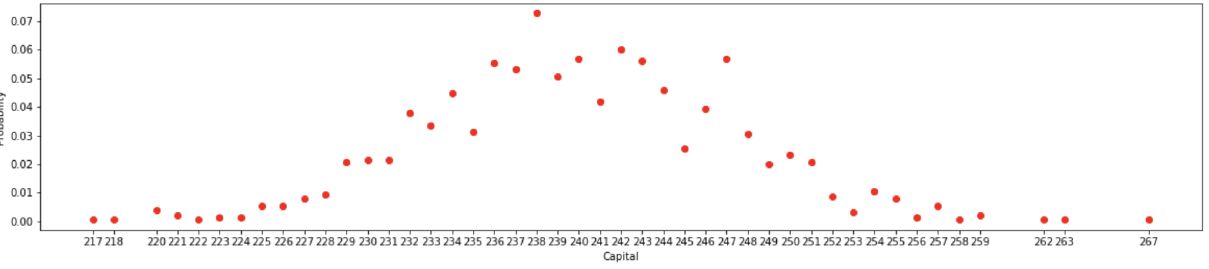
Figure 3. Probability of potential capital R(t) for u = 200, c = 20, m = 15, σ 2 = 4, t =